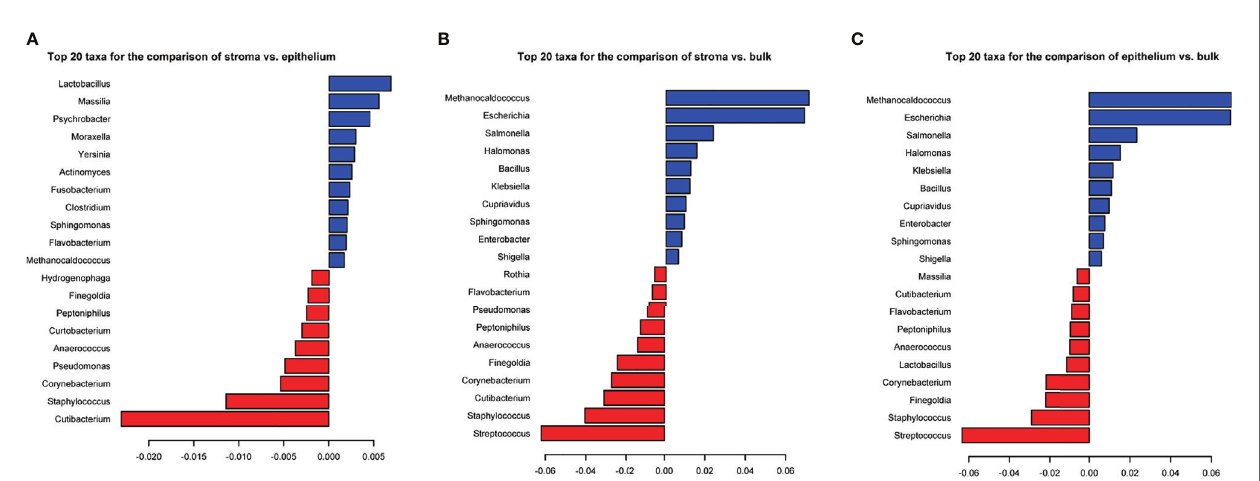
FIGURE 6 | The coef fi cients of top 20 taxa separating the stroma and epithelium samples (A) , the stroma and bulk samples (B) , and the epithelium and bulk samples (C) . PERMANOVA signi fi cance test is used for group-level differences. Red represents the negative coef fi cients and blue represents the positive coef fi